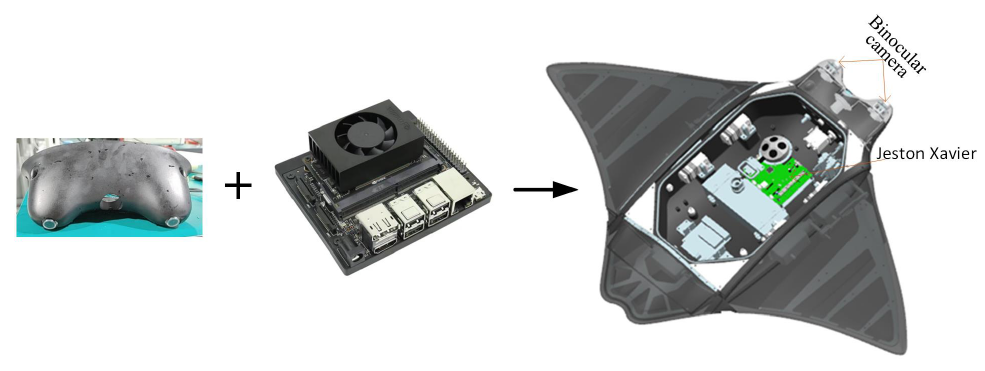
Figure 2. Design of the visual positioning system for UBMRV.